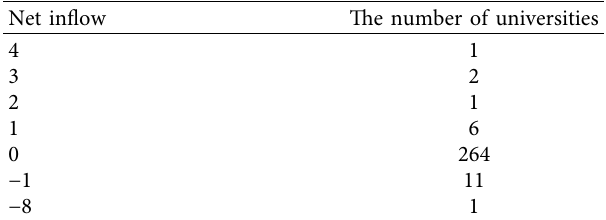
Table 3: The distribution of net talent flows of undergraduates. Net inflow